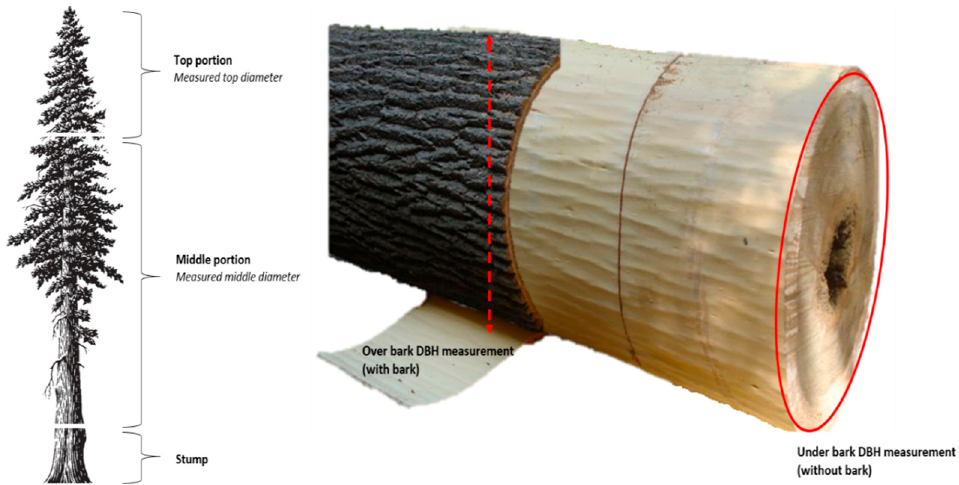
Figure 2. Over and under bark diameters measured with the harvest machine head (Source: adapted from www.archdaily.com, accessed on 12th June 2019).